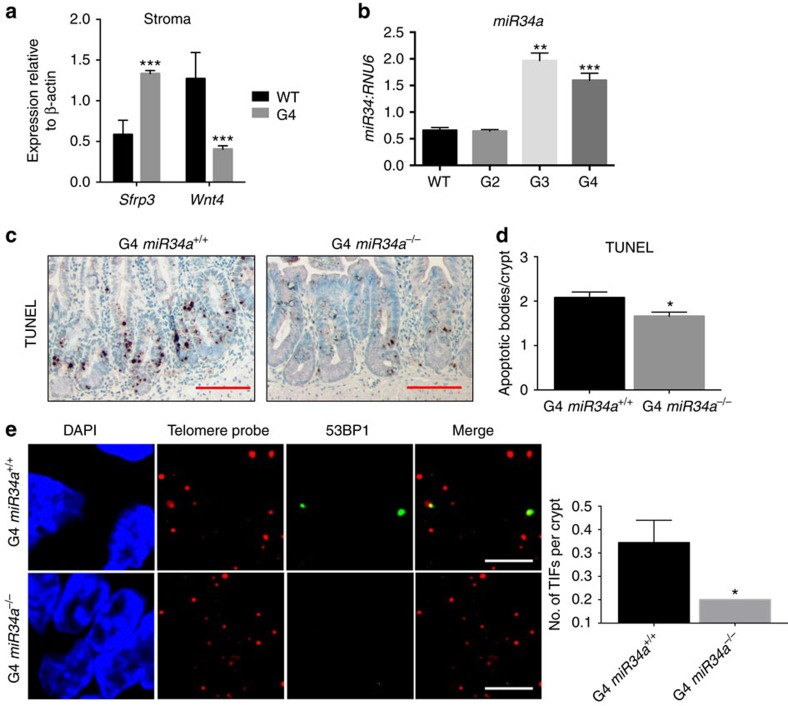
G4 mTR−/− mice have reduced expression of pro-Wnt pathway genes in ileal crypts and stroma.(a) Quantitative reverse transcription PCR (qRT-PCR) analyses of gene expression for the Wnt ligand (Wnt4) and Wnt receptor inhibitor (Sfrp3) in WT and G4 mTR−/− stroma (n=4). (b) qRT-PCR of miR34a in WT, G2, G3 and G4 mTR−/− crypts (n=4 for WT, G2, G3; n=7 for G4). (c) Representative images showing apoptotic changes by TUNEL staining of ileum of G4 mTR−/−
miR34a+/+ mice and G4 mTR−/−
miR34a−/−mice. Scale bar, 50 μm. (d) Quantitation of TUNEL-positive apoptotic bodies per crypt (n=6). (e) Representative images showing reduced telomere dysfunction as measured by TIFs in G4 mTR−/−
miR34a−/−mice compared to littermate G4 mTR−/−
miR34a+/+mice (n=4). Quantitation of TIFs (right). Scale bar, 5 μm. All error bars reflect s.e.m., and P values reflect unpaired two-tailed Student's t-tests, with *P<0.05, **P<0.005 and ***P<0.0005.